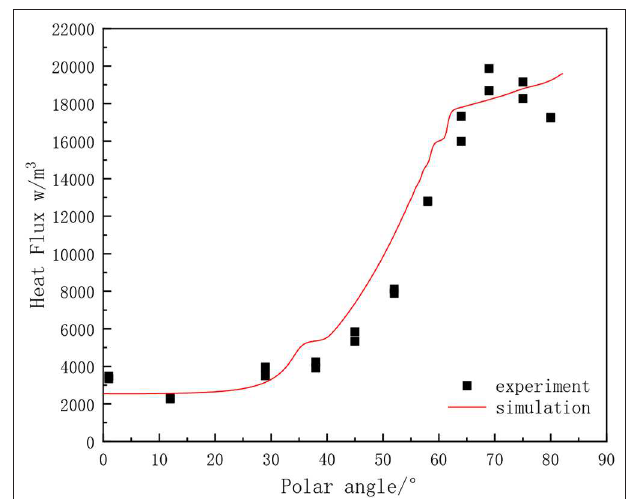
FIGURE 3 | Temperature distribution in the corium pool.